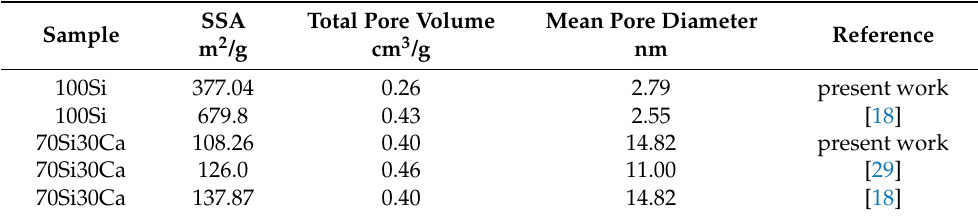
Table 2. Specific surface area, pore volume, and pore diameter of the glasses prepared in the present work and the literature.